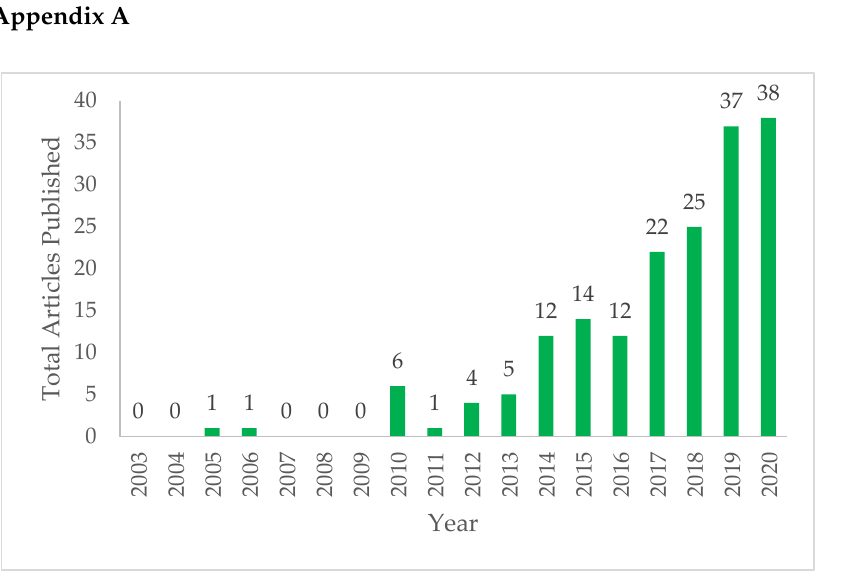
Table A1. Organization of discrete outcomes — as reported in each study — into broader outcome categories.